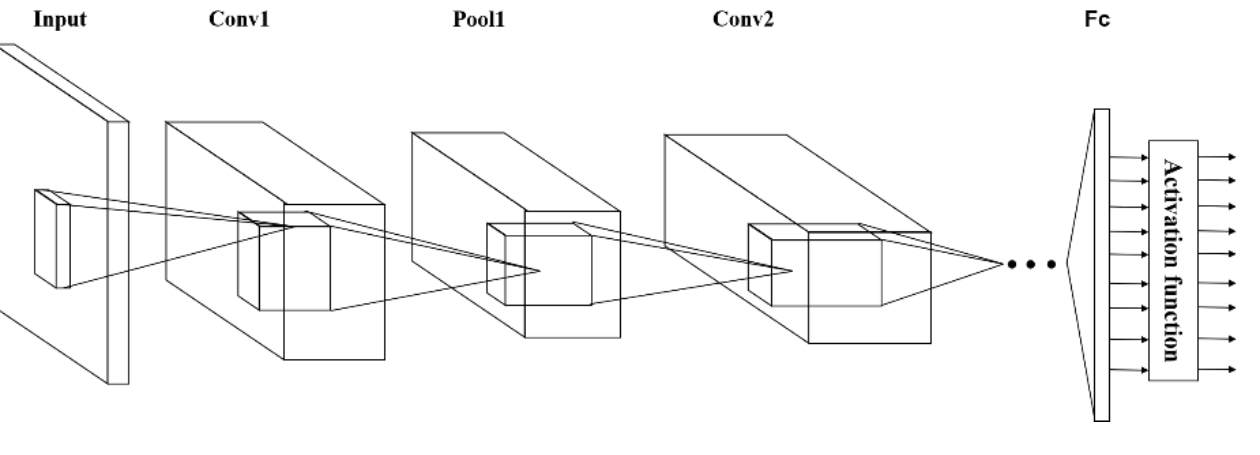
Figure 5. Typical CNN model.